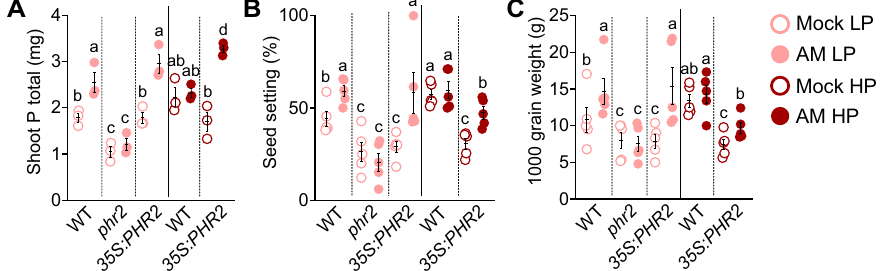
Fig. 5 PHR2 affects AM-mediated phosphate uptake and yield in fi eld soil. A Total shoot phosphorus (mg), B seed setting, and C 1000 grain weight of the indicated genotypes inoculated with R. irregularis (AM) or non-inoculated (Mock) and grown at LP (unfertilized) or HP (fertilized with superphosphate fertilizer, P 2 O 5 ). Plants were grown in a greenhouse in soil from the Longhua fi eld base in Shenzhen, China, and harvested at 110 days post transplanting (dpt) for trait quanti fi cation. Statistics: Individual data-points and mean ± SE are shown. N = 3 – 5 independent plants; Brown – forsythe and Welch ’ s One- Way ANOVA test with Games – Howell ’ s multiple comparison test was carried out. Different letters indicate statistical differences between genotypes and